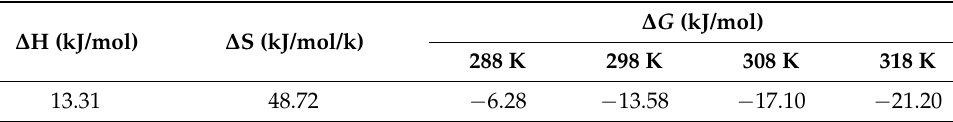
Table 4. Thermodynamic parameters for MB adsorbed on BAC.